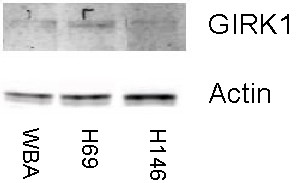
GIRK1 protein expression in SCLC cells that express GIRK1 mRNA as assessed by western blot analysis. In the three SCLC cell lines that expressed GIRK1 mRNA (Figure 1), membrane protein expression was determined. Top panel: All three SCLC cell lines (WBA, H69, H146) expressed GIRK1 membrane protein. Bottom panel: Actin was used as a control for equal sample loading. The bands are consistent with the expected size: GIRK1-62 kDa; actin-42 kDa.